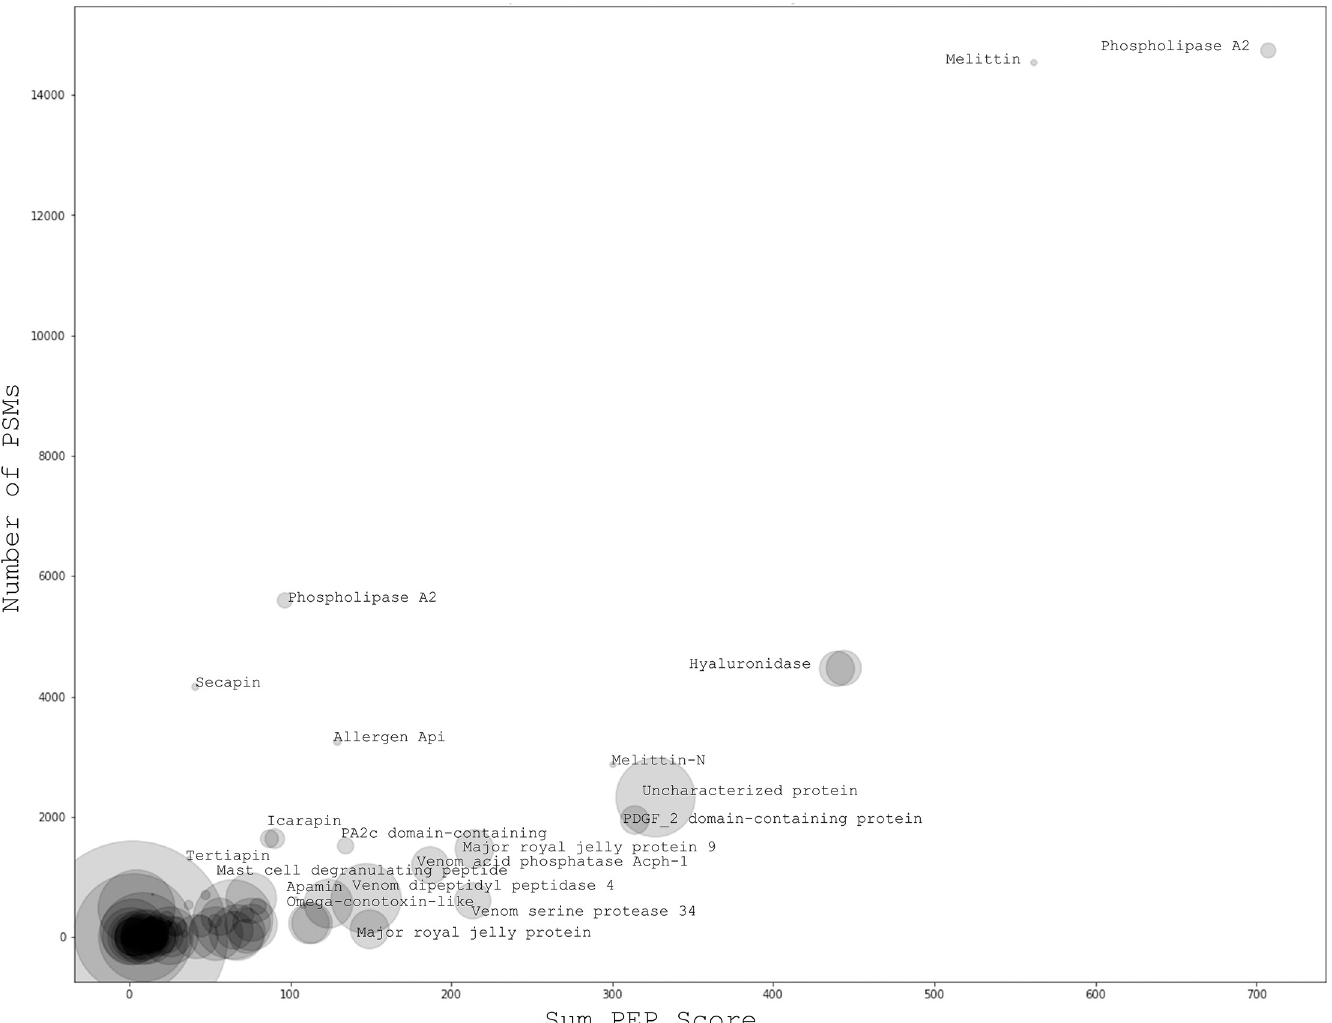
Fig 3. The major contributing compositional proteins of bee venom, as determined by LC-MS/MS. Higher abundant proteins represented by the combined peptide match score (Sum PEP Score) and number of peptide spectrum matches (PSMs). Bubble size indicates molecular weight; S3 Table presents the full list of proteins with relative names and molecular